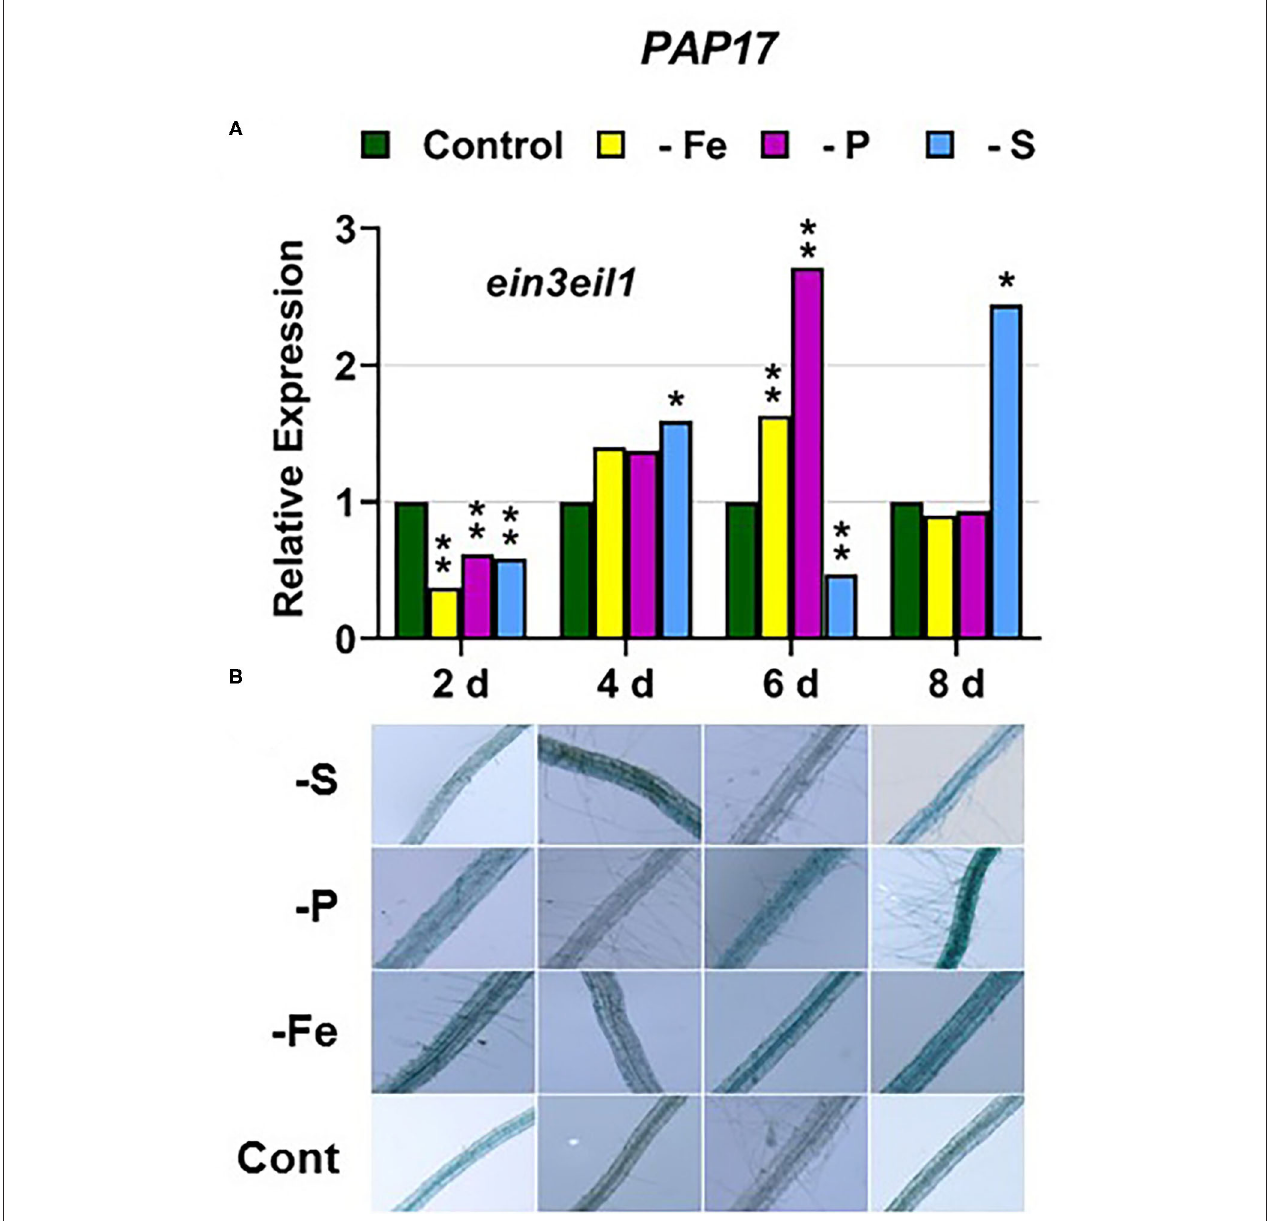
FIGURE 8 | Effect of Fe, P or S deficiency on the expression of the P-related gene PAP17 (A) ; and of phosphatase activity (PA; B ) in roots of the Arabidopsis ethylene mutant ein3eil1 . Treatments and determinations as in Figure 5 . Within each day and genotype, * or ** indicate significant differences ( P < 0.05 or P < 0.01) in relation to the control